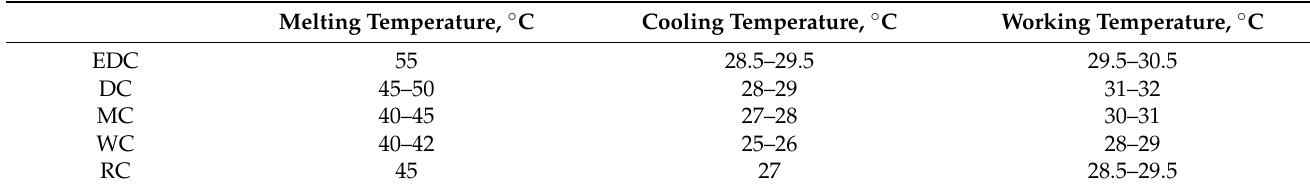
Table 2. Specific tempering temperatures of chocolate